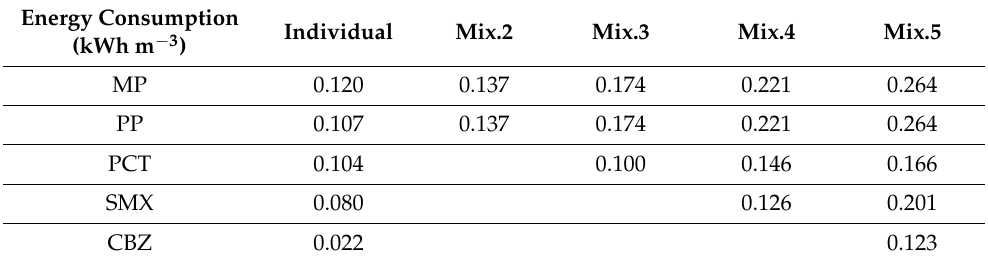
Table 6. Energy consumption for PPCPs removal individually or in mixture through ozone